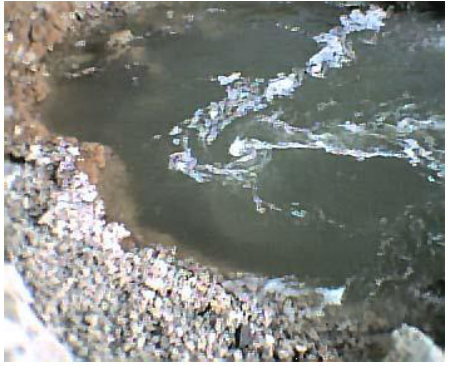
Figure 18. Appearance of vortex